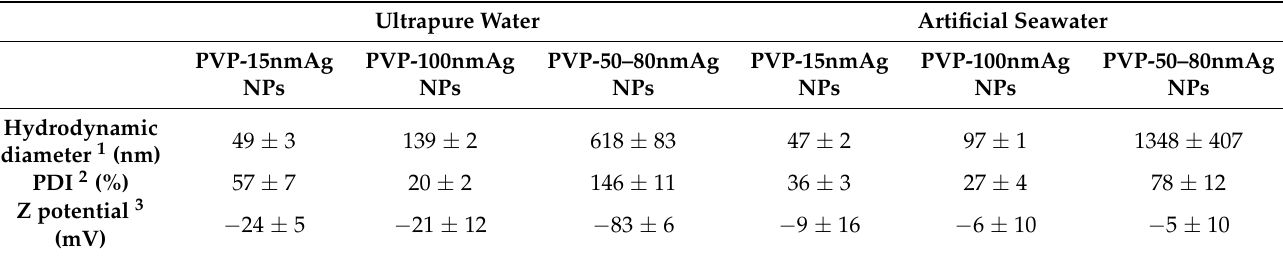
Table 1. Physicochemical characterization of selected AgNPs. Ultrapure Water Artificial